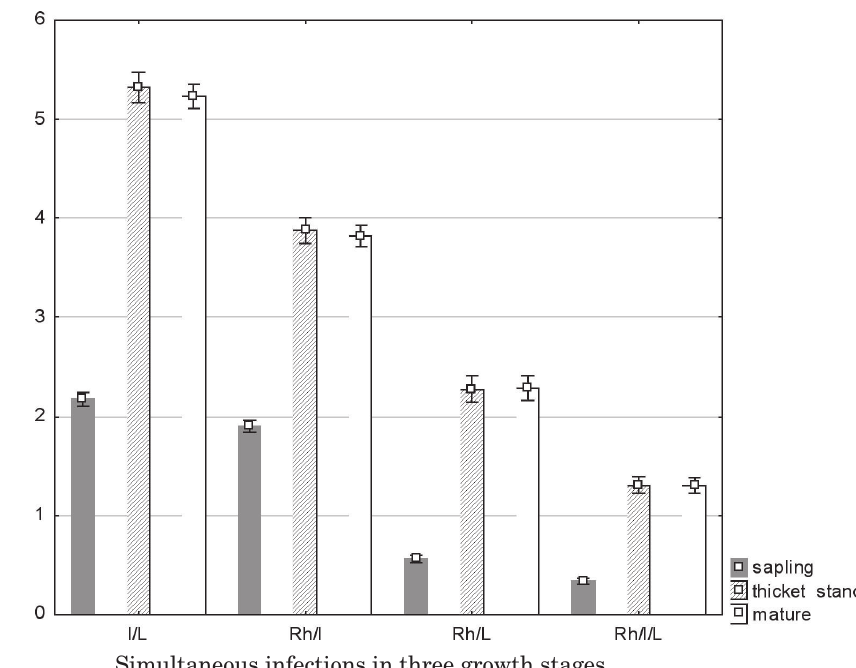
Fig. 4. Mean frequency of needles, from trees of 3 growth stages, infected simultaneously with “l” and “L” (l/L); “Rh” and l (Rh/l); “Rh” and “L” (Rh/L); “Rh”, “l” and “L”. Whiskers represent standard errors ( P